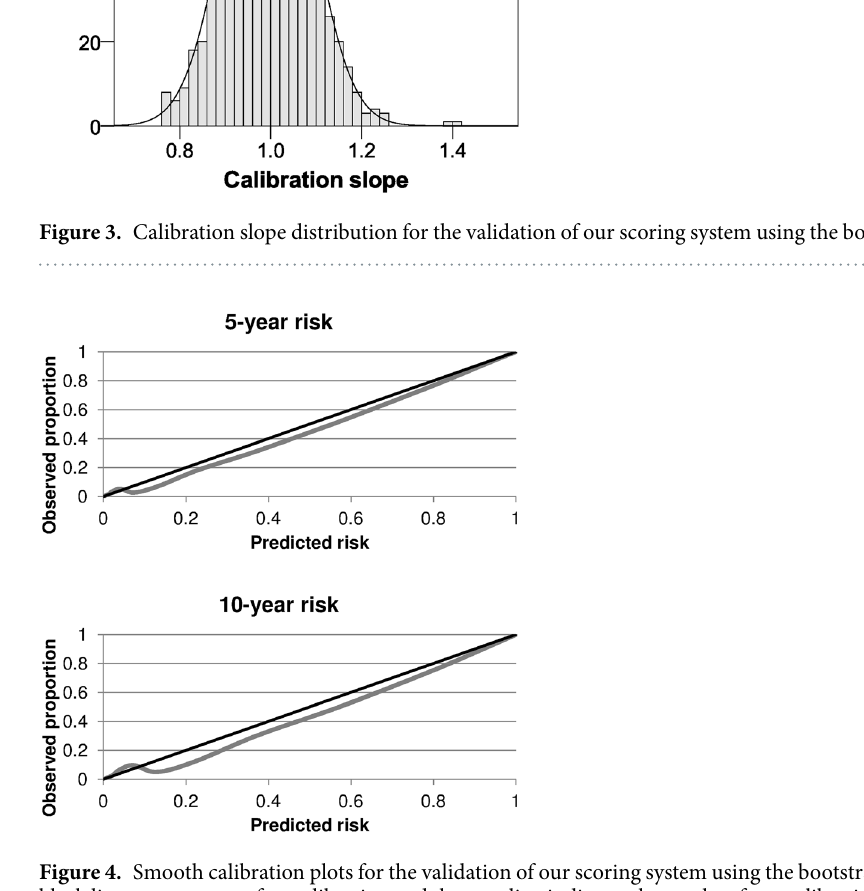
Figure 4. Smooth calibration plots for the validation of our scoring system using the bootstrap method. The black line represents perfect calibration and the grey line indicates the results of our